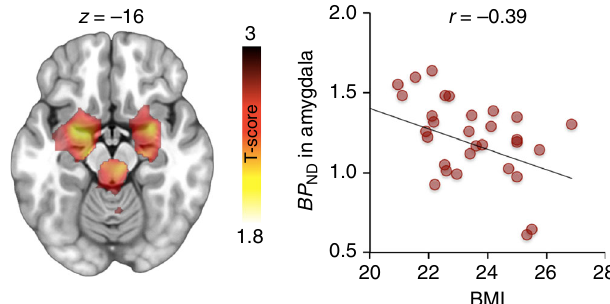
Fig. 3 Association between BMI and MOR availability in the amygdala ( n = 33). The full-volume data are shown at p < 0.05 uncorrected for visualization purposes